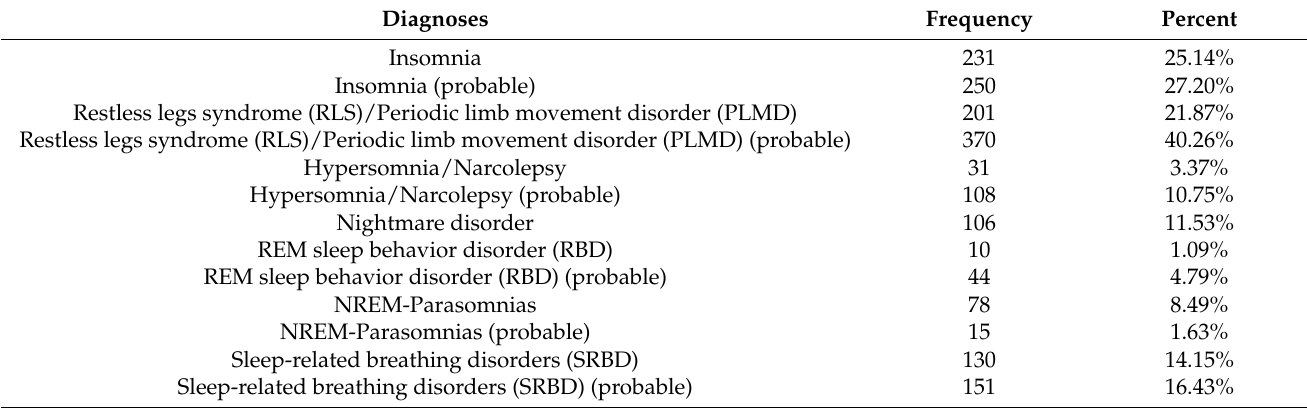
Table 1. Diagnoses (multiple diagnoses possible) ( n =